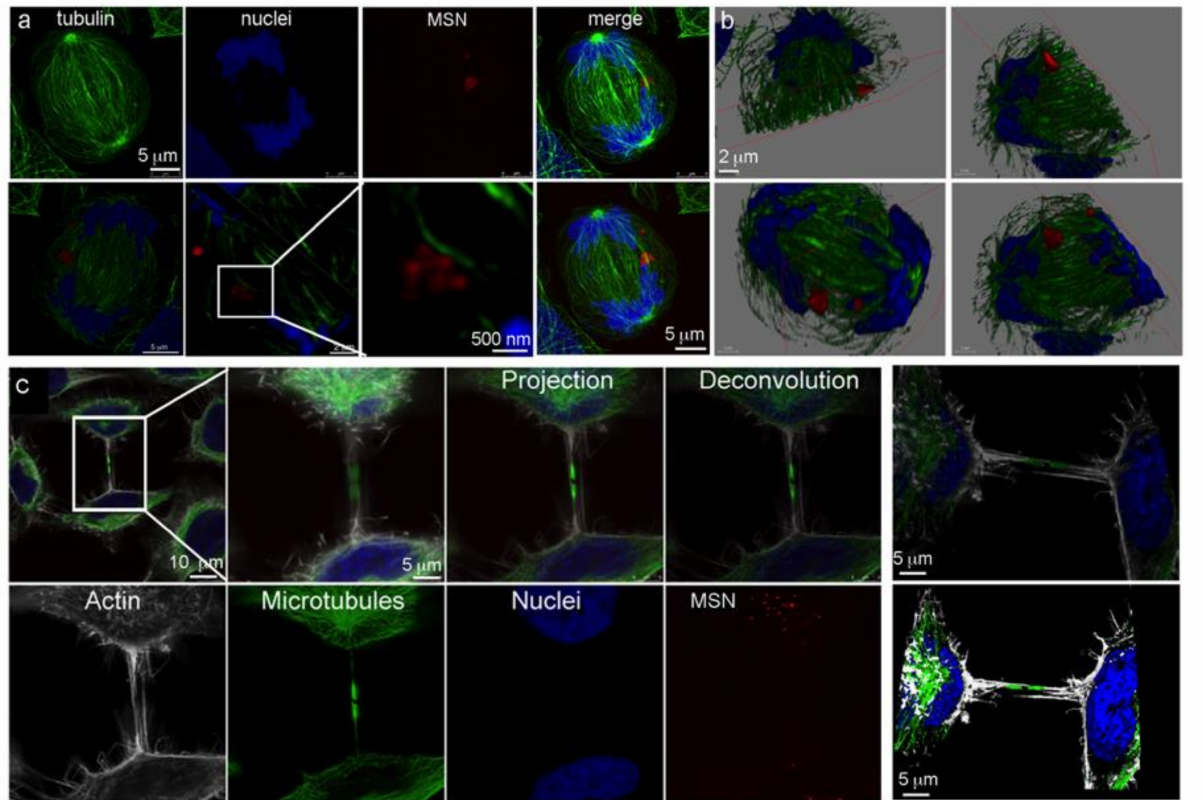
Figure 5. MSN-endolysosome localization during anaphase and telophase in HeLa cells. ( a , b ) Huygens deconvoluted fluorescent projection ( a ) and 3D ( b ) micrographs showing sister chromatid separation during anaphase (green: microtubules; anti- α -tubulin antibody-AF488; red: MSN; DyLight 594; blue: nuclei, DAPI). 3D images are displayed with and without sectioning. ( c ) Projection and 3D micrographs of a late cytokinetic HeLa cell containing internalized Cy3-MSN (red). Cells were labeled post fixation with AF647 phalloidin (white; actin), AF488 anti- α -tubulin antibody (green; microtubules) and DAPI (blue;